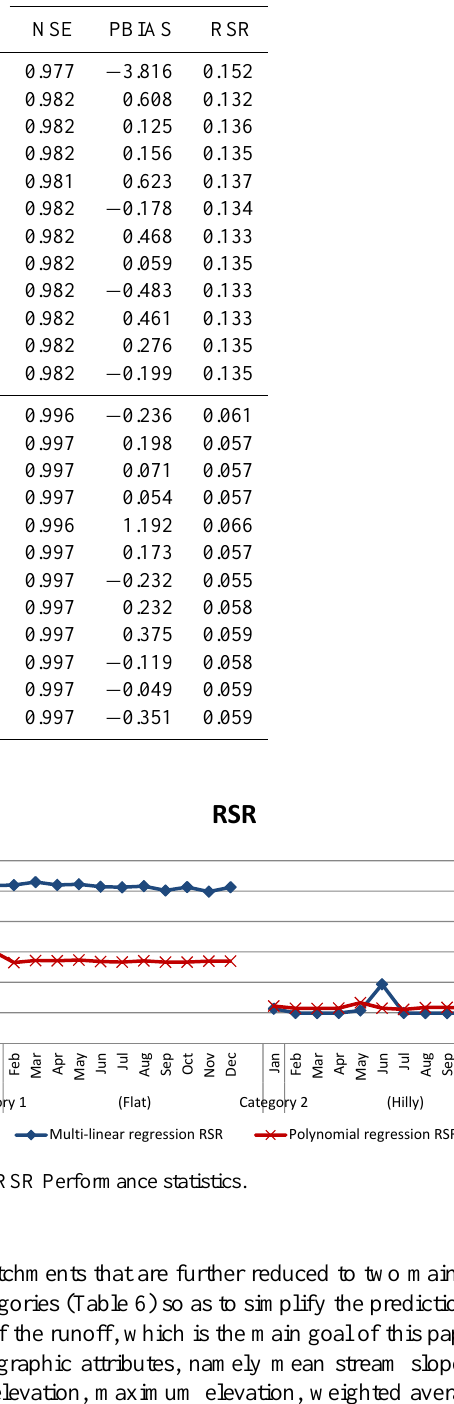
Figure 10 NSE Performance statistics